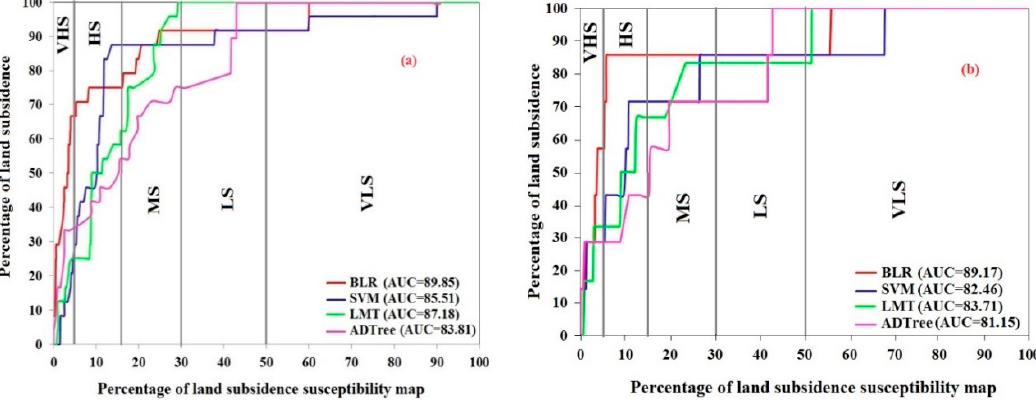
Figure 6. Model validation and comparison using ( a ) success rate curve and ( b ) prediction rate curve.